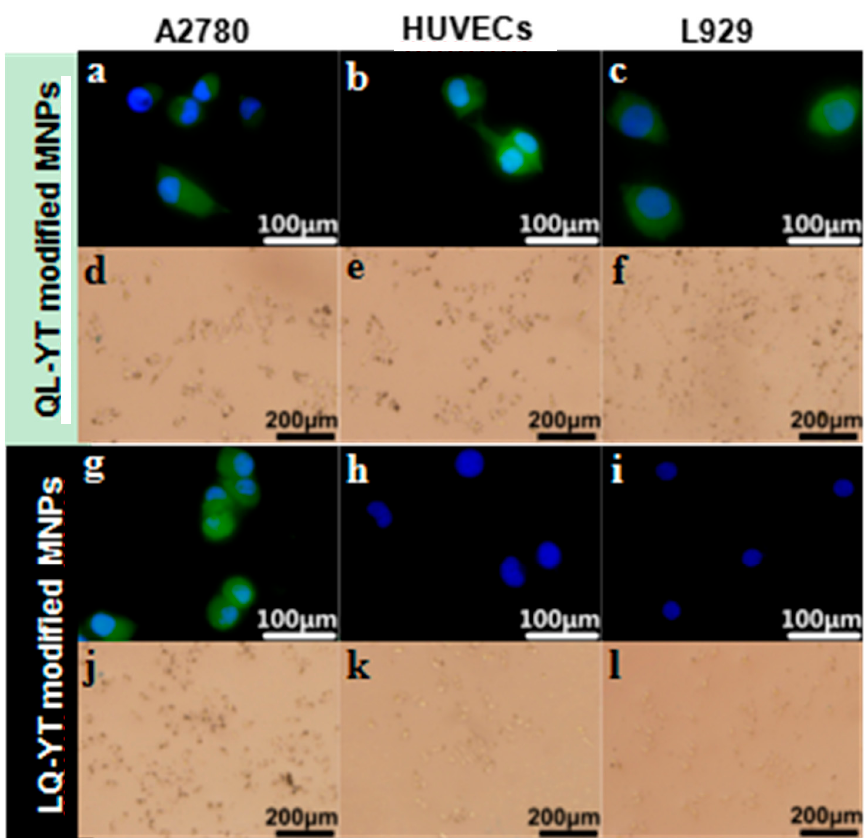
Figure 5. Immunofluorescence images of ( g – i ) LQ-YT modified Fe 3 O 4 -MNPs and ( a – c ) QL-YT modified Fe 3 O 4 -MNPs; Prussian blue staining images of ( j – l ) LQ-YT modified Fe 3 O 4 -MNPs and ( d – f) QL-YT modified Fe 3 O 4 -MNPs.